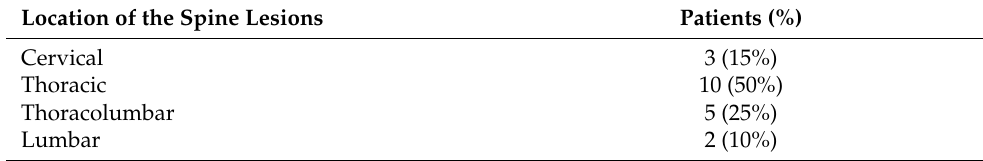
Table 2. Location of the spine